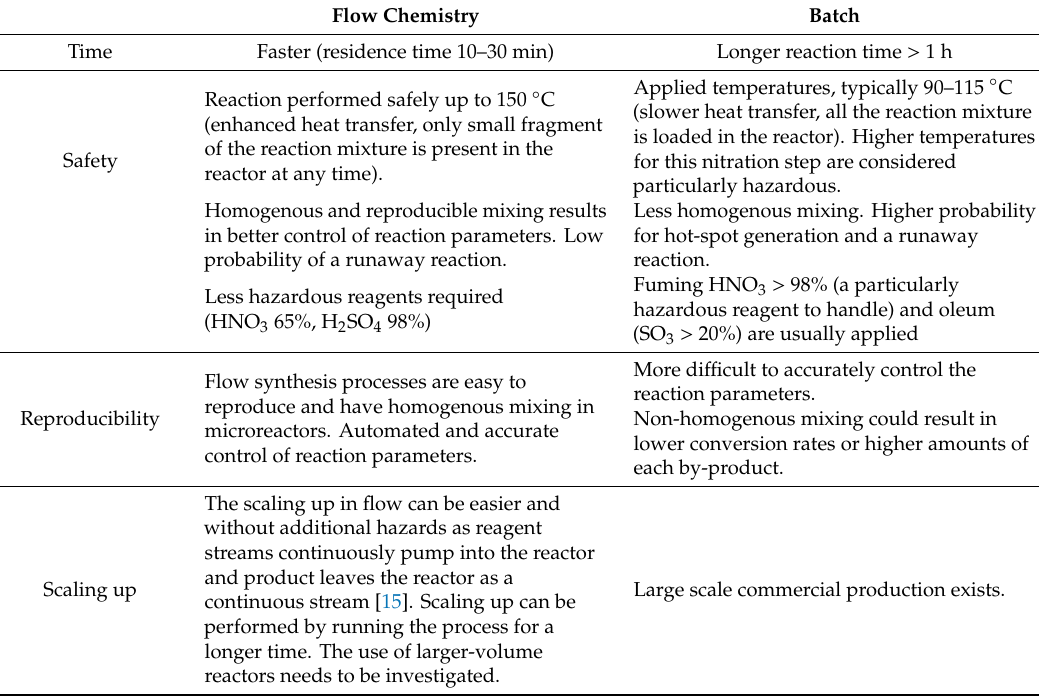
Table 2. Comparison of the conventional batch process and flow synthesis for the third nitration step for TNT